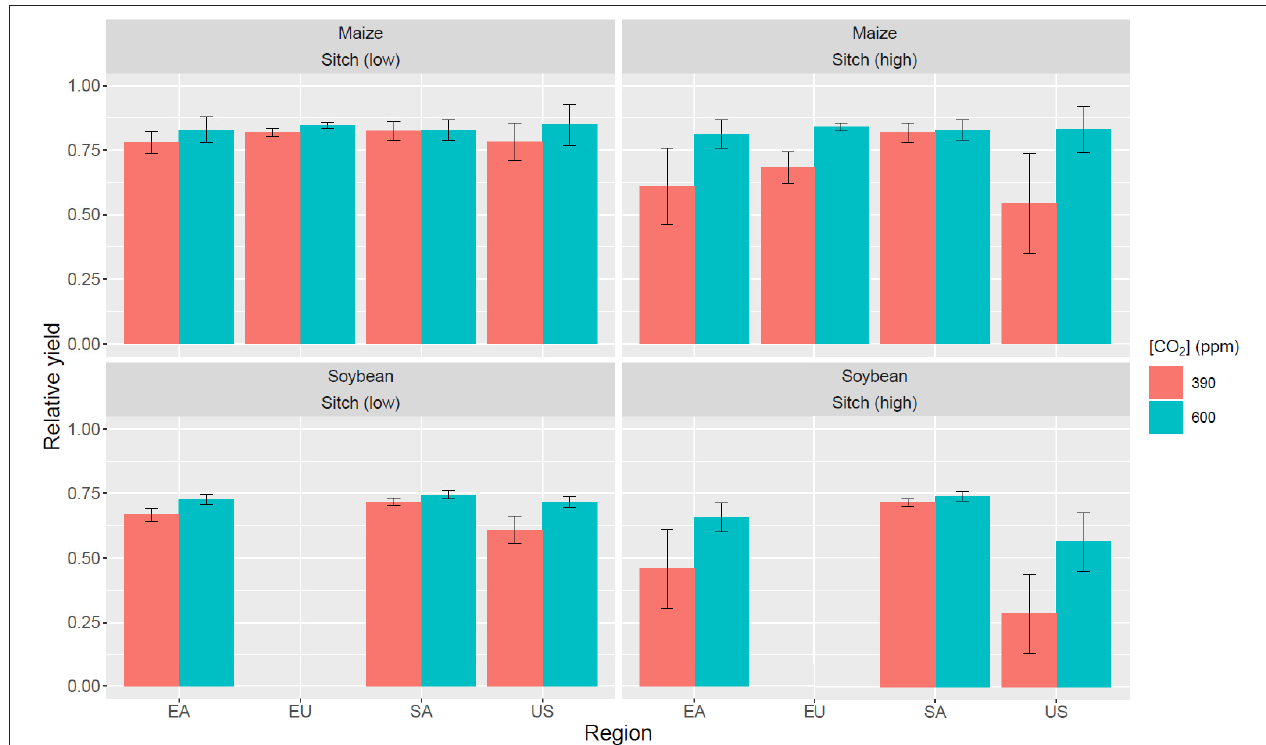
FIGURE 13 | Summary of TEMIR-simulated relative yield at four different regions under 390 and 600 ppm CO 2 concentration. The error bar represents one standard deviation of the data. Data that is above the 95th percentile or below the 5th percentile is